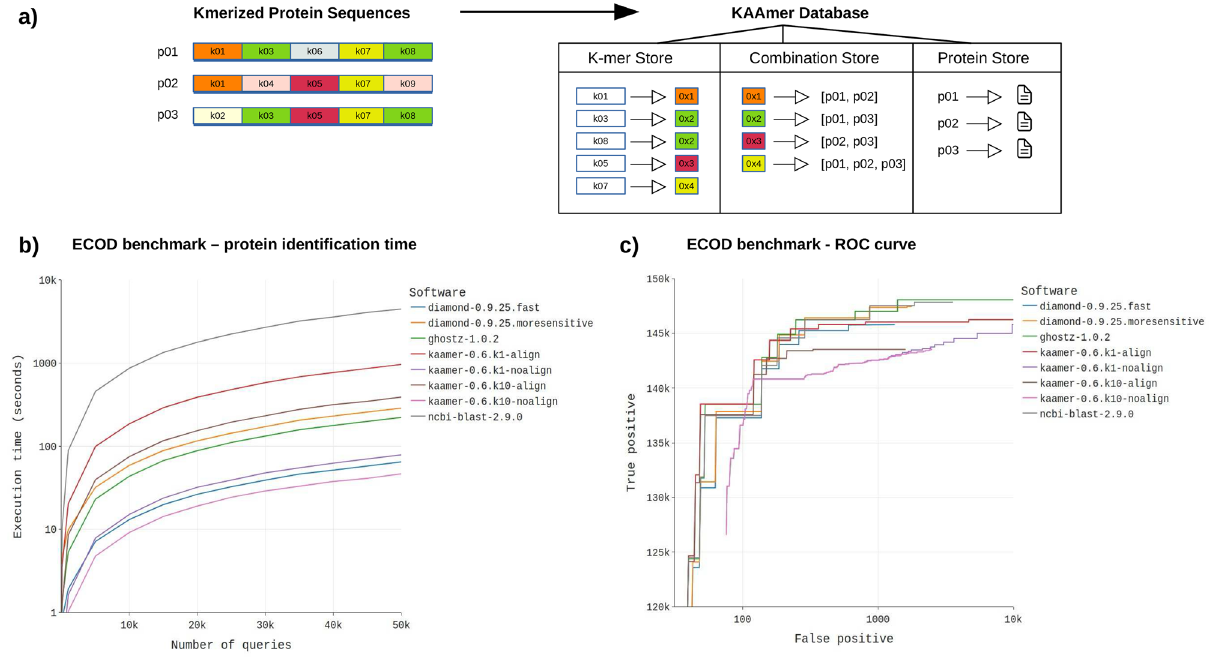
Figure 1. ( a ) Design of a kAAmer database. Three key-value stores are created within a database (K-mer Store, Combination Store, Protein Store). Colours indicate the combination (hash) values that are reused in the combination store. Proteins are numbered (p01, p02, p03) and k-mers are numbered (k01, k02, ..., k08). ( b ) Protein search speed benchmark. Software include Blastp (v2.9.0+), Ghostz (v1.0.2), Diamond (v0.9.25) and kAAmer (v0.6) with (-aln) and without (-kmatch) alignment. ( c ) Protein search precision and recall benchmark with the ECOD database. The blue bars indicate the precision results and the red bars indicate the recall results. Software include Blastp (v2.9.0+), Ghostz (v1.0.2), Diamond (v0.9.25) and kAAmer (v0.6) with